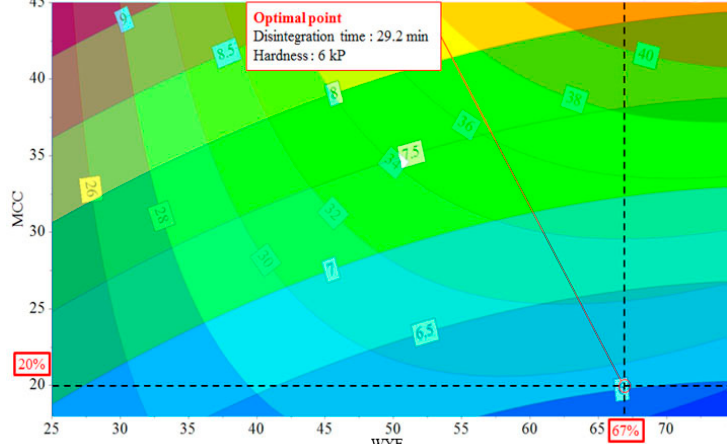
Figure 7. Overlaid response contour plot for the effects of microcrystalline cellulose (MCC) vs. Wuzi Yanzong dry extract (WYE) on disintegration time and hardness.